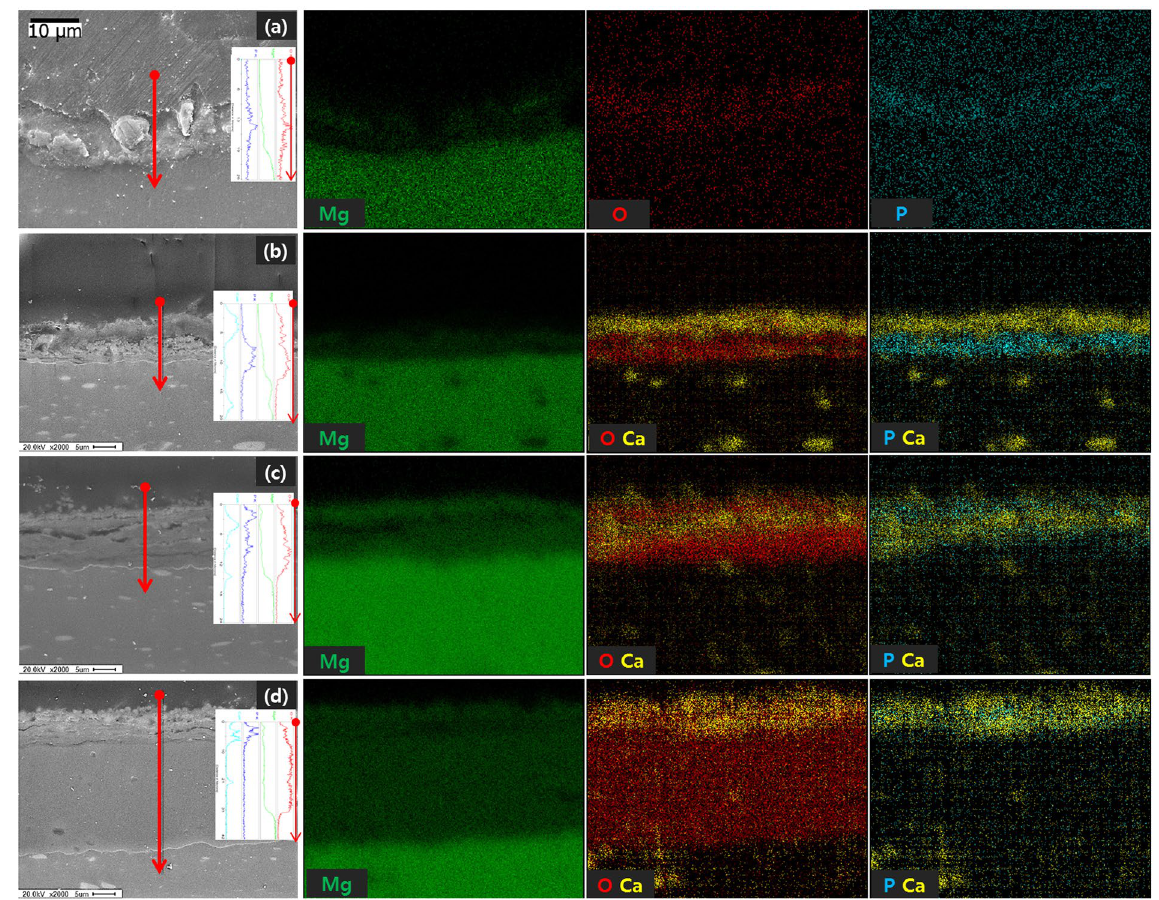
Figure 3. Cross-sectional image and line scans of surfaces film after ( a ) anodization, ( b ) Ca deposition post anodization anodizing, ( c ) hydrothermal treatment at 120 °C, and ( d ) hydrothermal treatment at 150